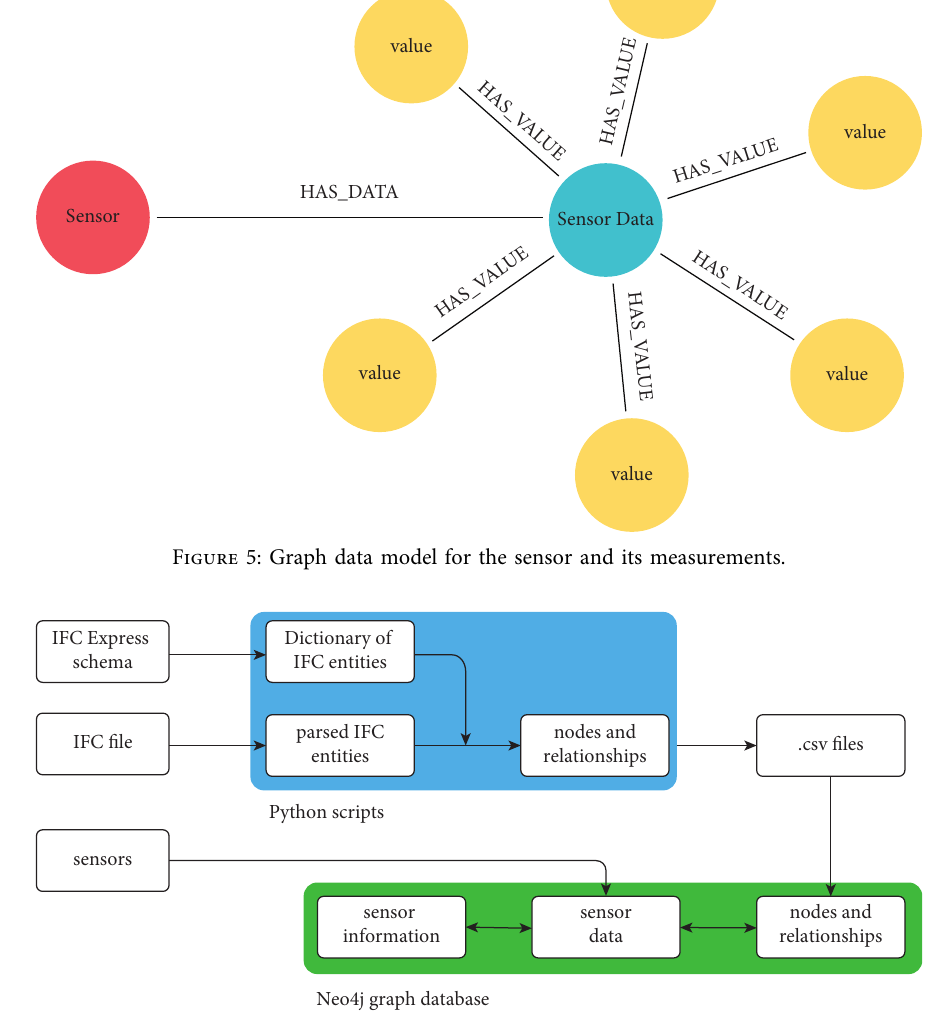
Figure 6: Workflow for converting IFC and sensor data into a graph database.